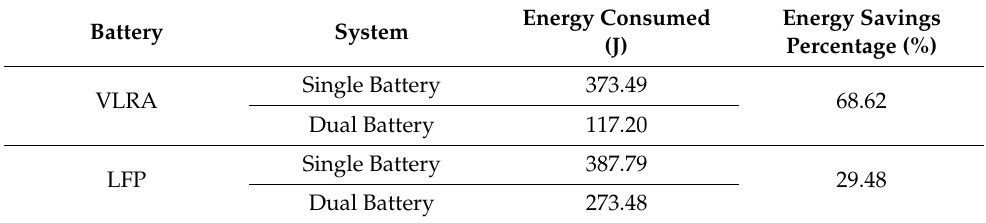
Table 4. Comparison of battery energy use and energy